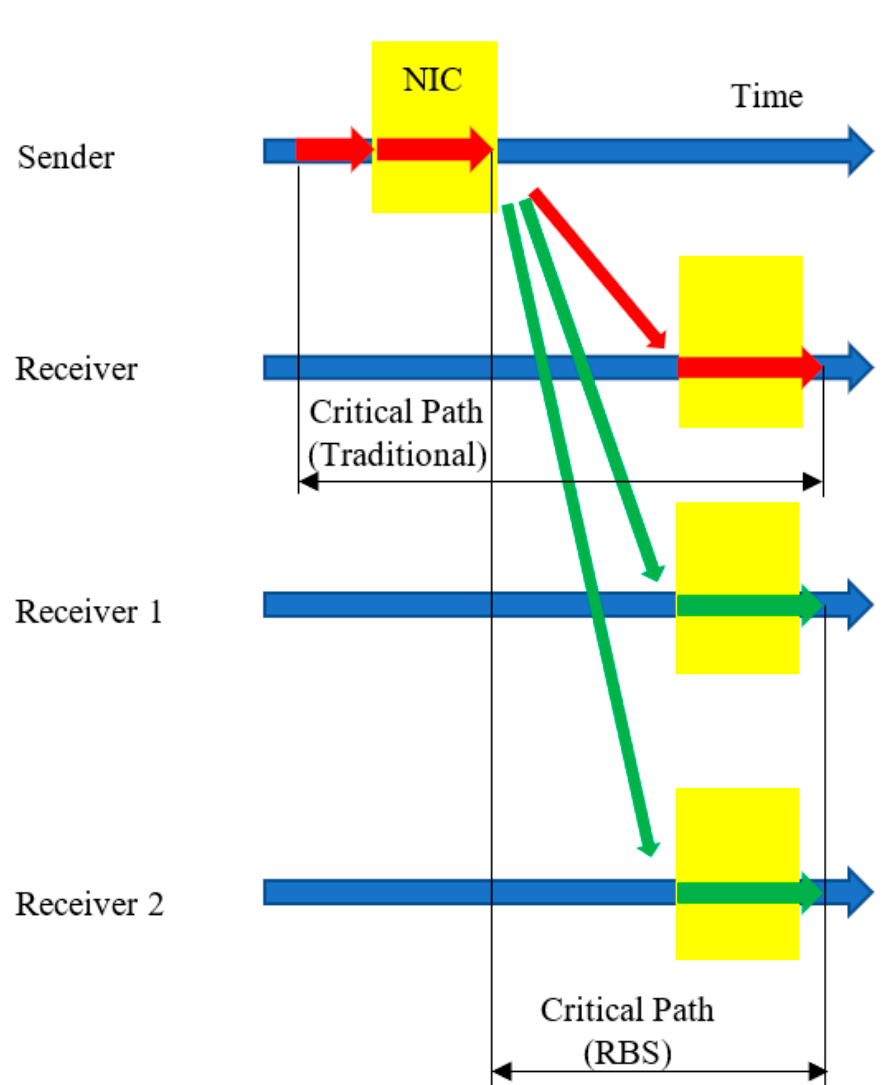
Figure 11. Critical path analysis (RBS protocol).